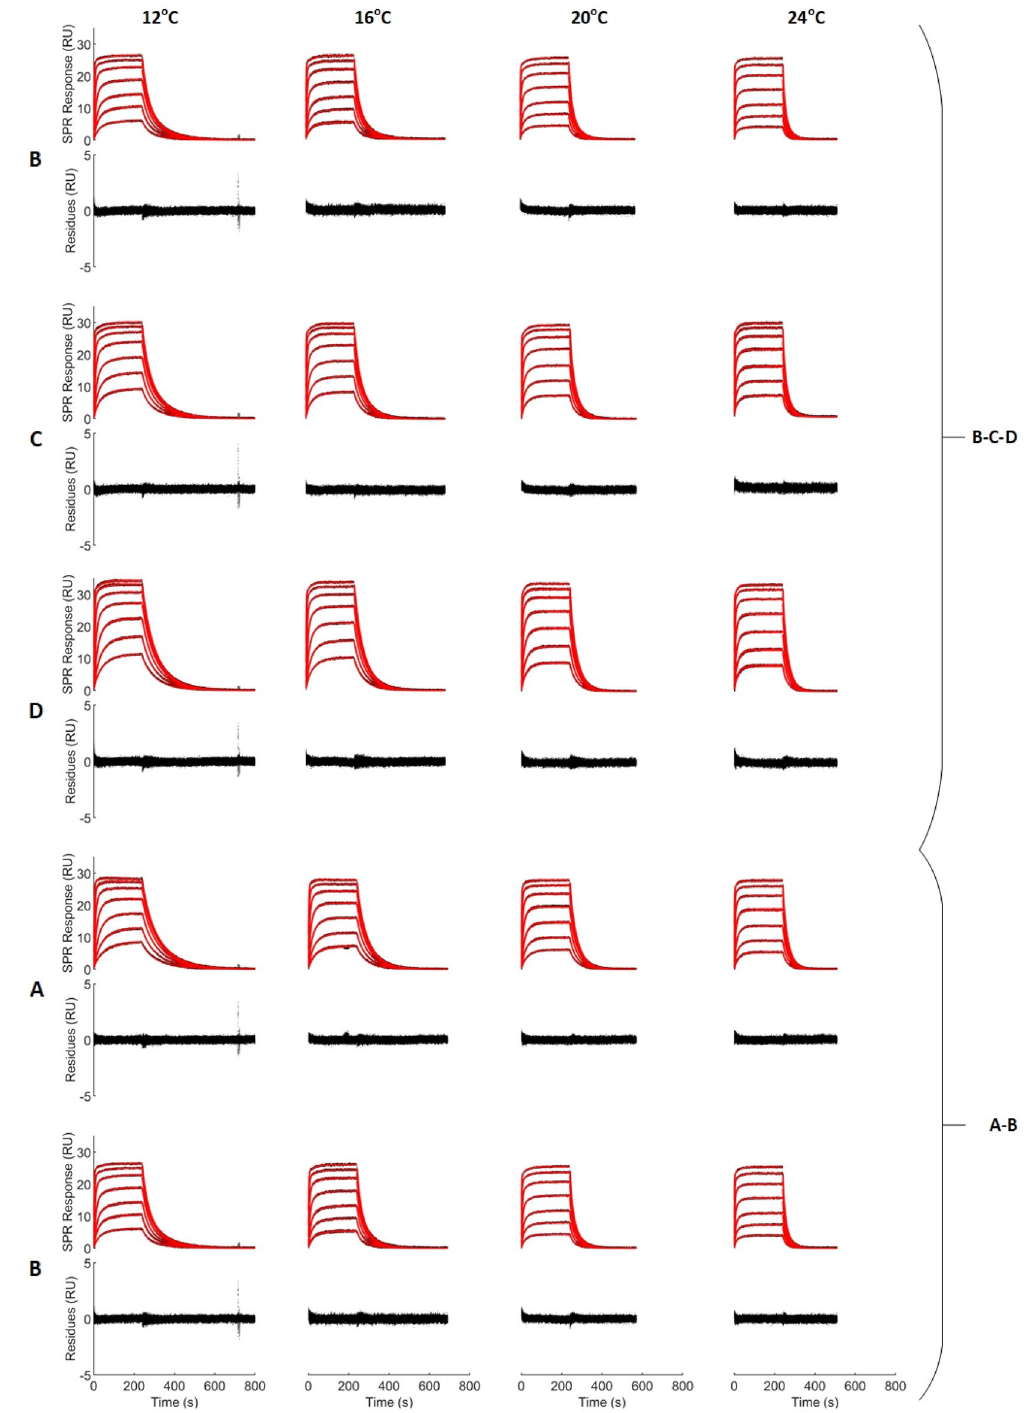
Figure 4. Kinetics analysis of the injection of mixtures of four compounds at four temperatures. Black dots correspond to control-corrected and double-referenced sensorgrams. Red lines correspond to ‘global- global-global’ fits for each data set (B–C–D and A–B, see Table 1 for exact mixture compositions). The total concentration ( C TOT ) of the mixtures ranged from 350 nM to 22,400 nM for all mixtures and temperatures. Here, the composition and total concentration are assumed to be known. The related residual plot is given below each sensorgram data